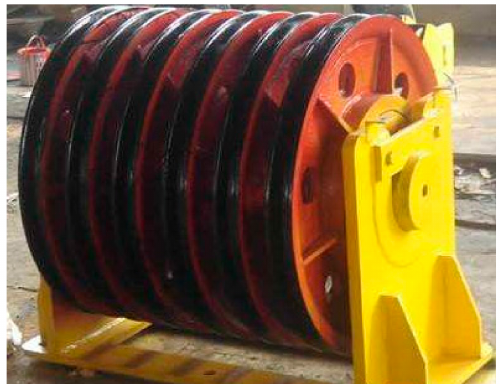
Figure 1. Pulley group without